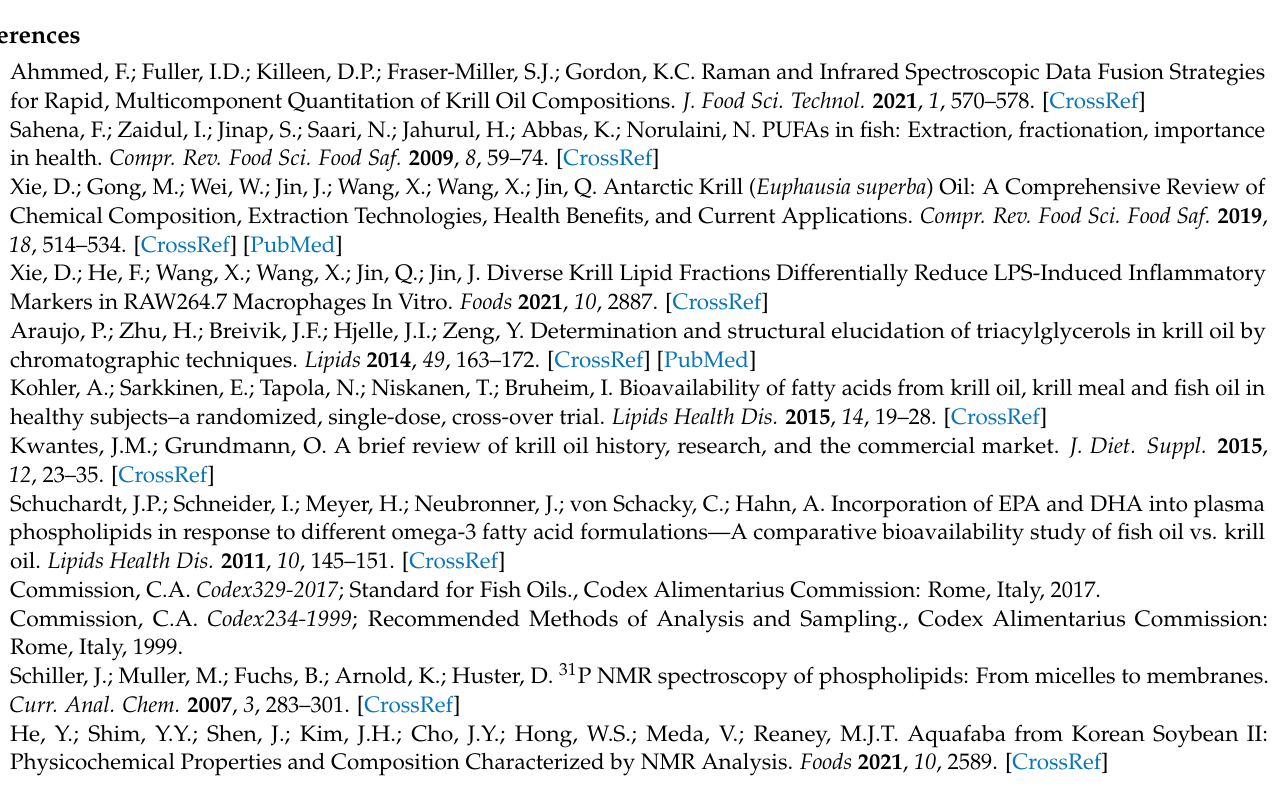
NMR spectrum of fish oil (PL free), Figure S3: Comparison of FT-IR spectra of a 1:1 mixture of krill oil raw material and fish oil with those produced after adding (a) PE and (b) PC standards to that mixture, Figure S4: Comparison of PC and total PL contents in krill oil test samples obtained from the FT-IR and 31 P NMR methods, Table S1: Accuracy of the FT-IR method for PC with